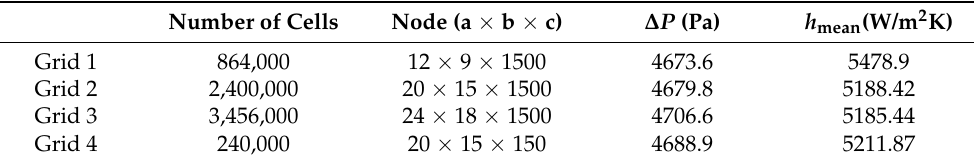
Table 4. Grid independence test of base fluid at Re =